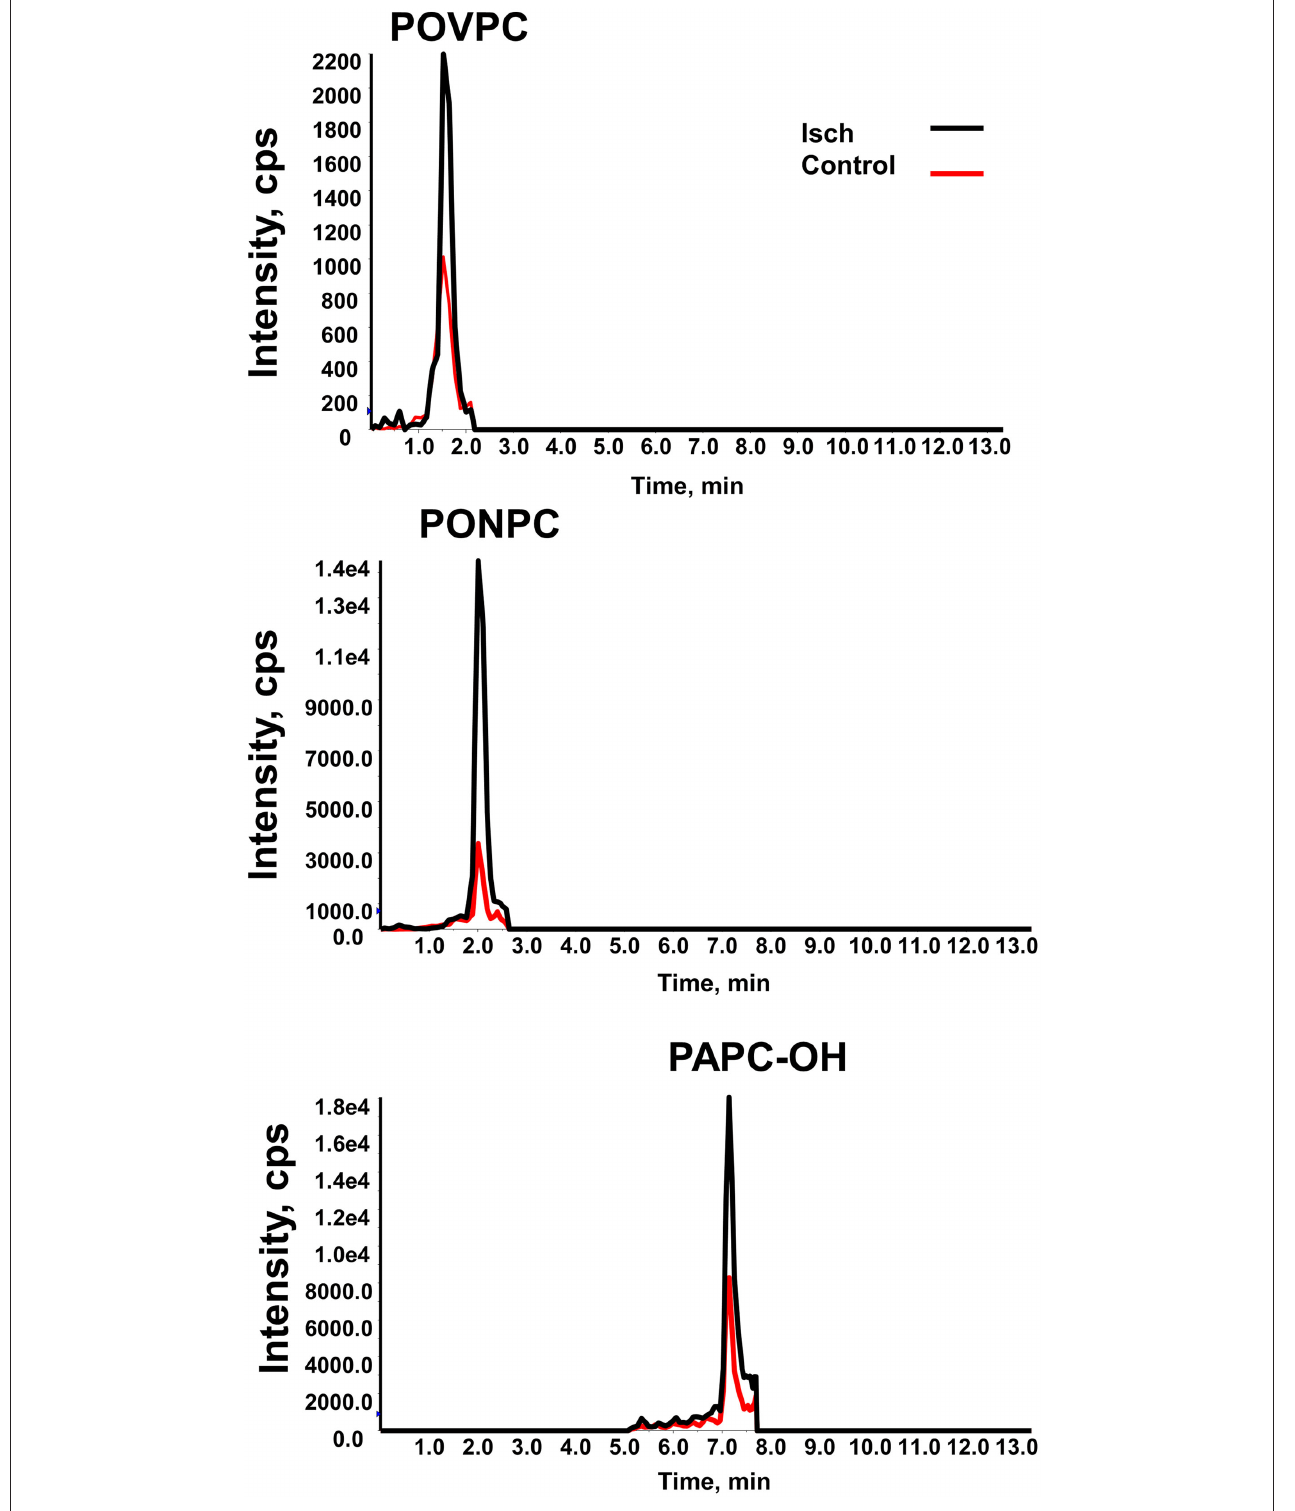
FIGURE 2 | MRM chromatogram of OxPC species. MRM chromatograms of POVPC, PONPC and PAPC-OH in STEMI patients (black line) and controls (red line) measured by reverse-phase LC-MS/MS.